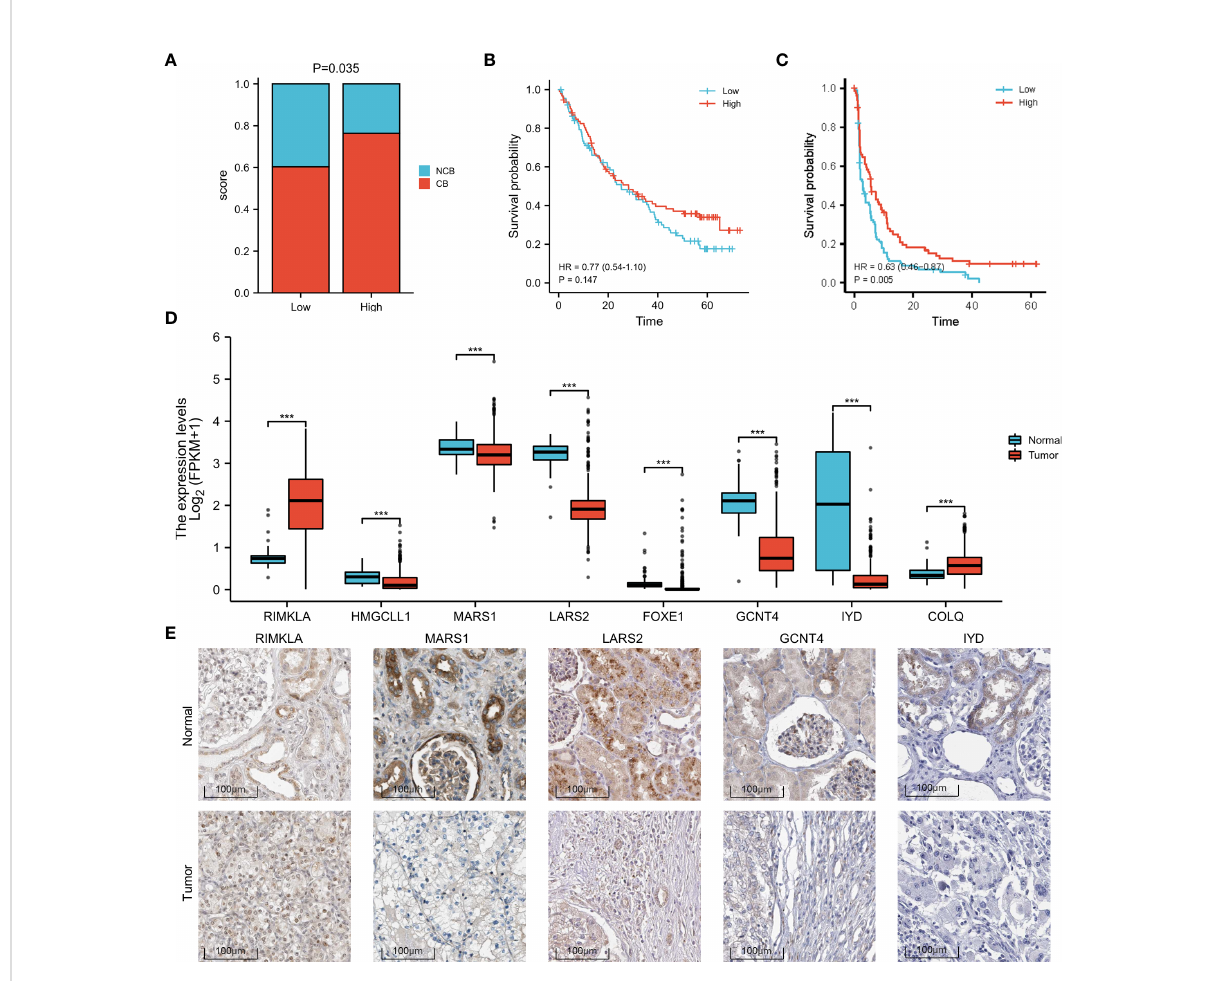
FIGURE 4 Increased response to anti-PD-1 immunotherapy in high-risk patients with ccRCC and differences in the expression of the signature genes. (A) Proportion of CB versus NCB in patients with high- or low-risk scores. (B) OS in high- and low-risk patients who underwent anti-PD-1 immunotherapy. (C) PFS in high- and low-risk patients who underwent anti-PD-1 immunotherapy. (D) Box plot of the difference in expression of signature genes between normal and ccRCC tissues, according to TCGA sequencing data. (E) The expression difference of RIMKLA , MARS1 , LARS2 , GCNT4 , and IYD between tumor and normal tissues at the protein level, according to Human Protein Atlas (HPA) cohort. OS, overall survival; PFS, progress free survival. ***p <